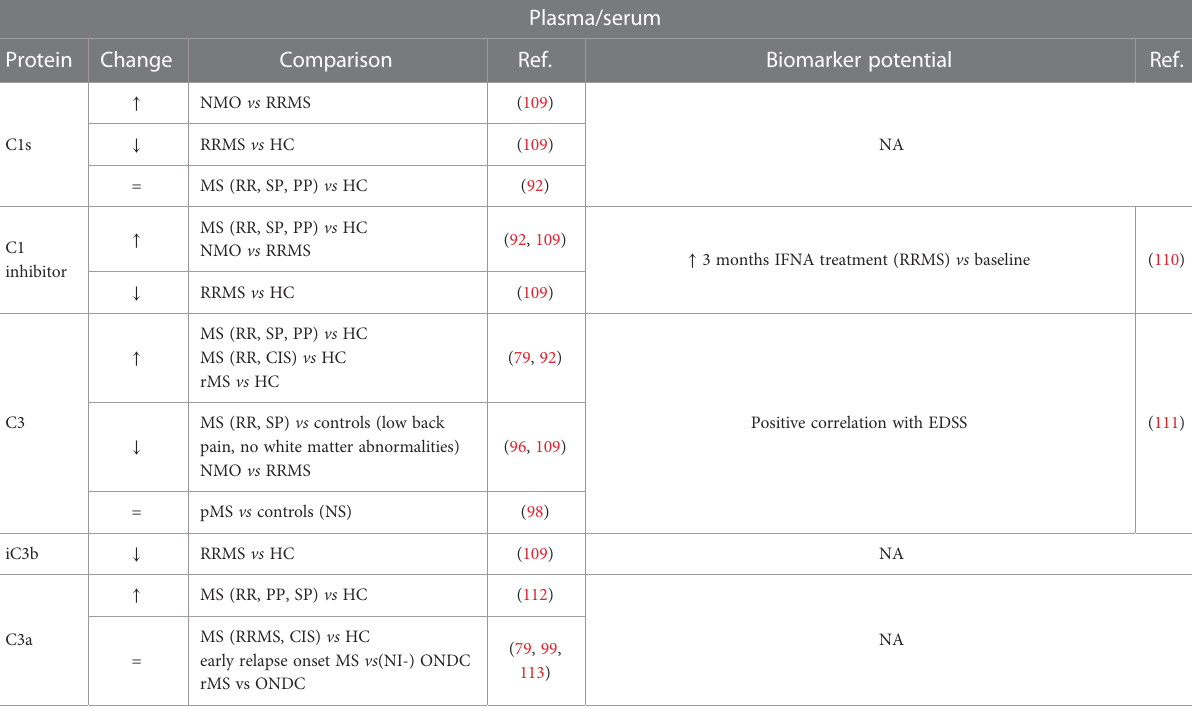
TABLE 4 Overview and biomarker potential of complement components evaluated in plasma or serum of multiple sclerosis (MS) patients compared to a control group. Plasma/serum Protein Change Comparison Ref. Biomarker potential